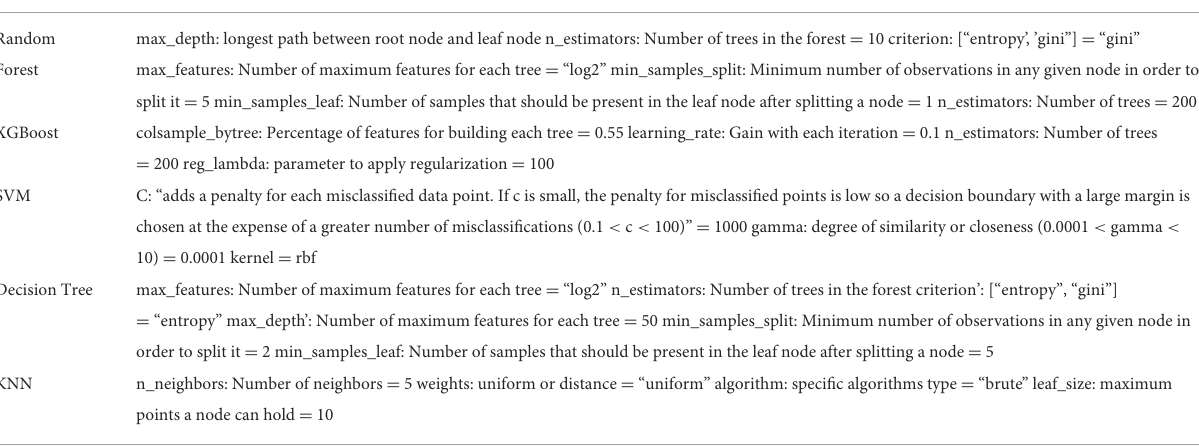
TABLE 2 Hyperparameters used in models. Model